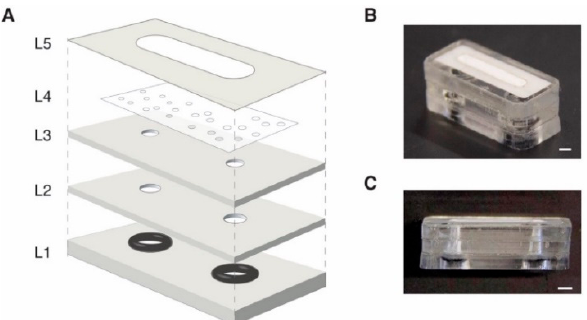
Figure 1. ( A ) Exploded view of the RID module. L1–L3 are laser cut from polymethymethacrylate (PMMA). L1 and L2 have pressure sensitive adhesive on the top face to facilitate layer-to-layer lamination. L3 is the tubing stop layer used to prevent damage to L4, the porous, hydrophobic PTFE membrane. L5 is laser cut from polyester film and has PSA on the bottom surface to seal the edges of the PTFE membrane and prevent leakage. After assembly, an O-ring is inserted into the access ports in L1 to provide simple push-to-connect compression sealing to interface the device with tubing for fluid routing. ( B ) Isometric image of assembled RID module. Scale bar = 2 mm. ( C ) Side view of assembled device. Scale bar = 2 mm.